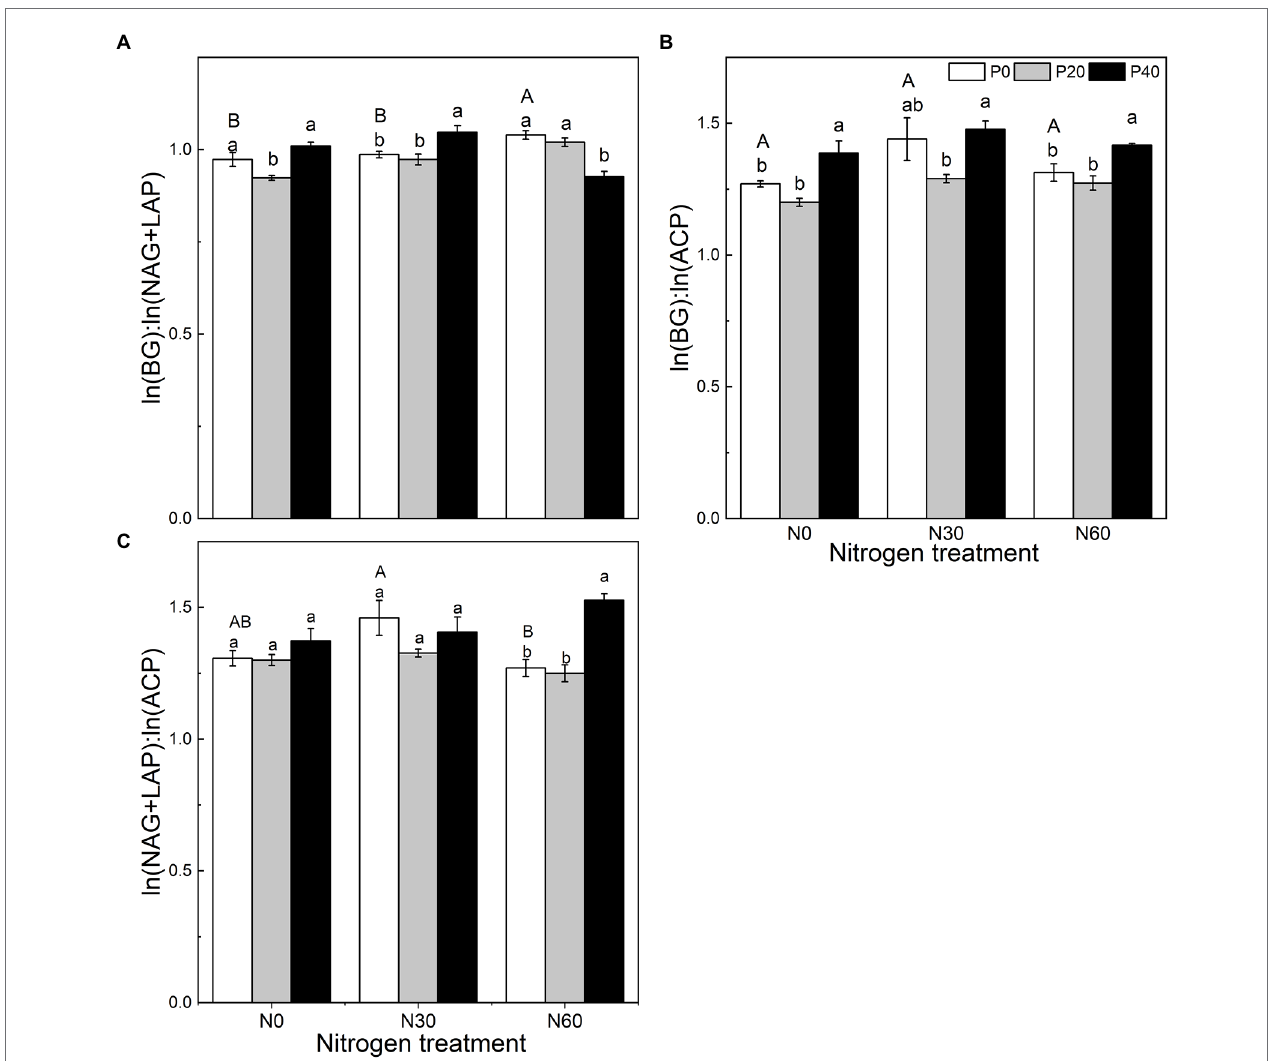
FIGURE 3 | The effect of simulated nitrogen (N) deposition and phosphorus (P) addition on the stoichiometric ratio of soil enzymes. (A) The enzyme C:N ratio. (B) The enzyme C:P ratio. (C) The enzyme N:P ratio. N0, 0 kg N ha − 2 year − 1 ; N30, 30 kg N ha − 2 year − 1 ; N60, 60 kg N ha − 2 year − 1 ; P0, 0 mg P kg − 1 ;